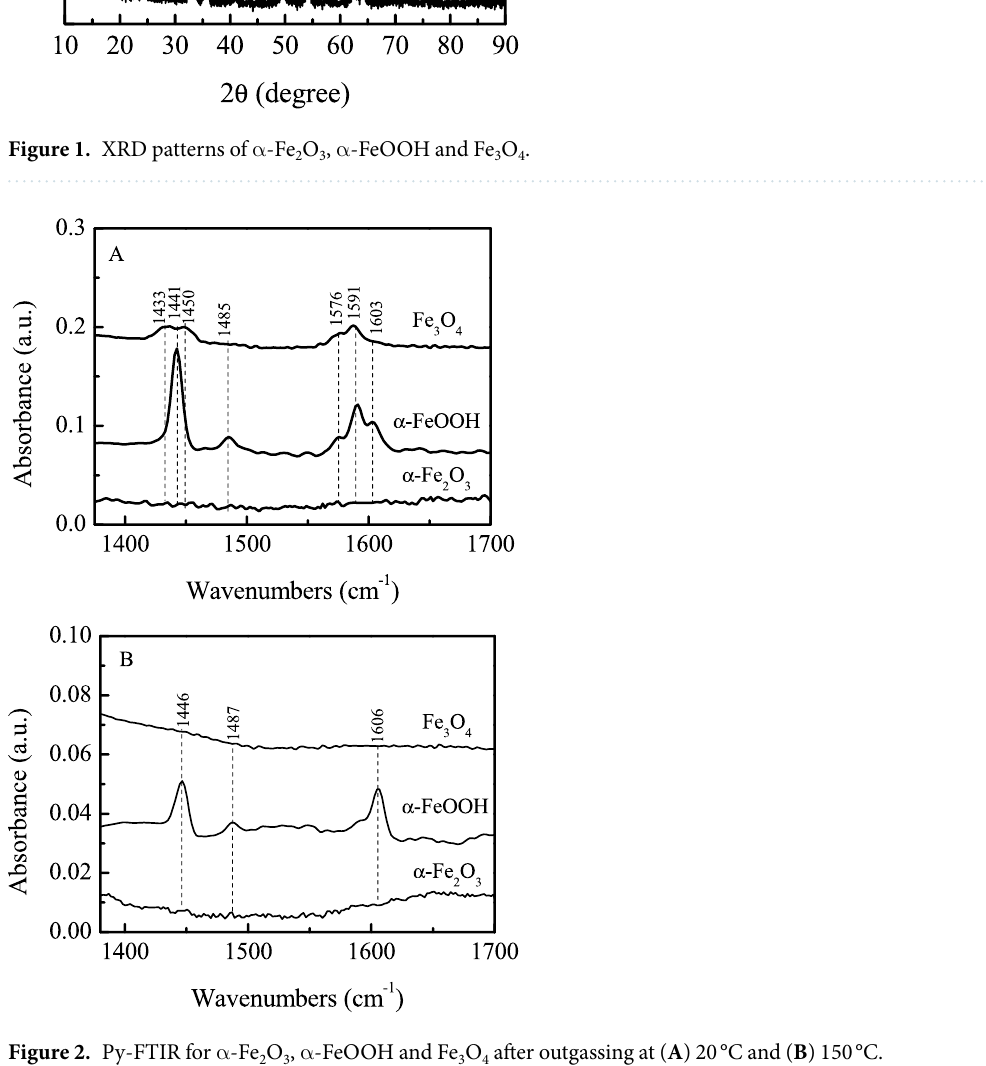
Figure 2. Py-FTIR for α -Fe 2 O 3 , α -FeOOH and Fe 3 O 4 after outgassing at ( A ) 20 °C and ( B ) 150